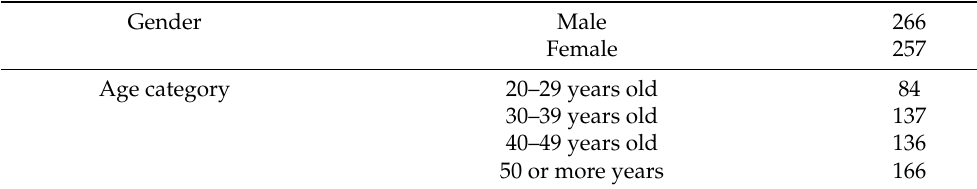
Table 4. Structure of the sample (number of respondents n =